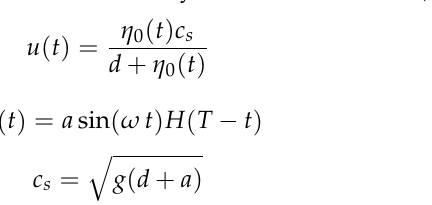
Figure 3. History of wave run-up along the vertical seawall for the single-crest wave train case.